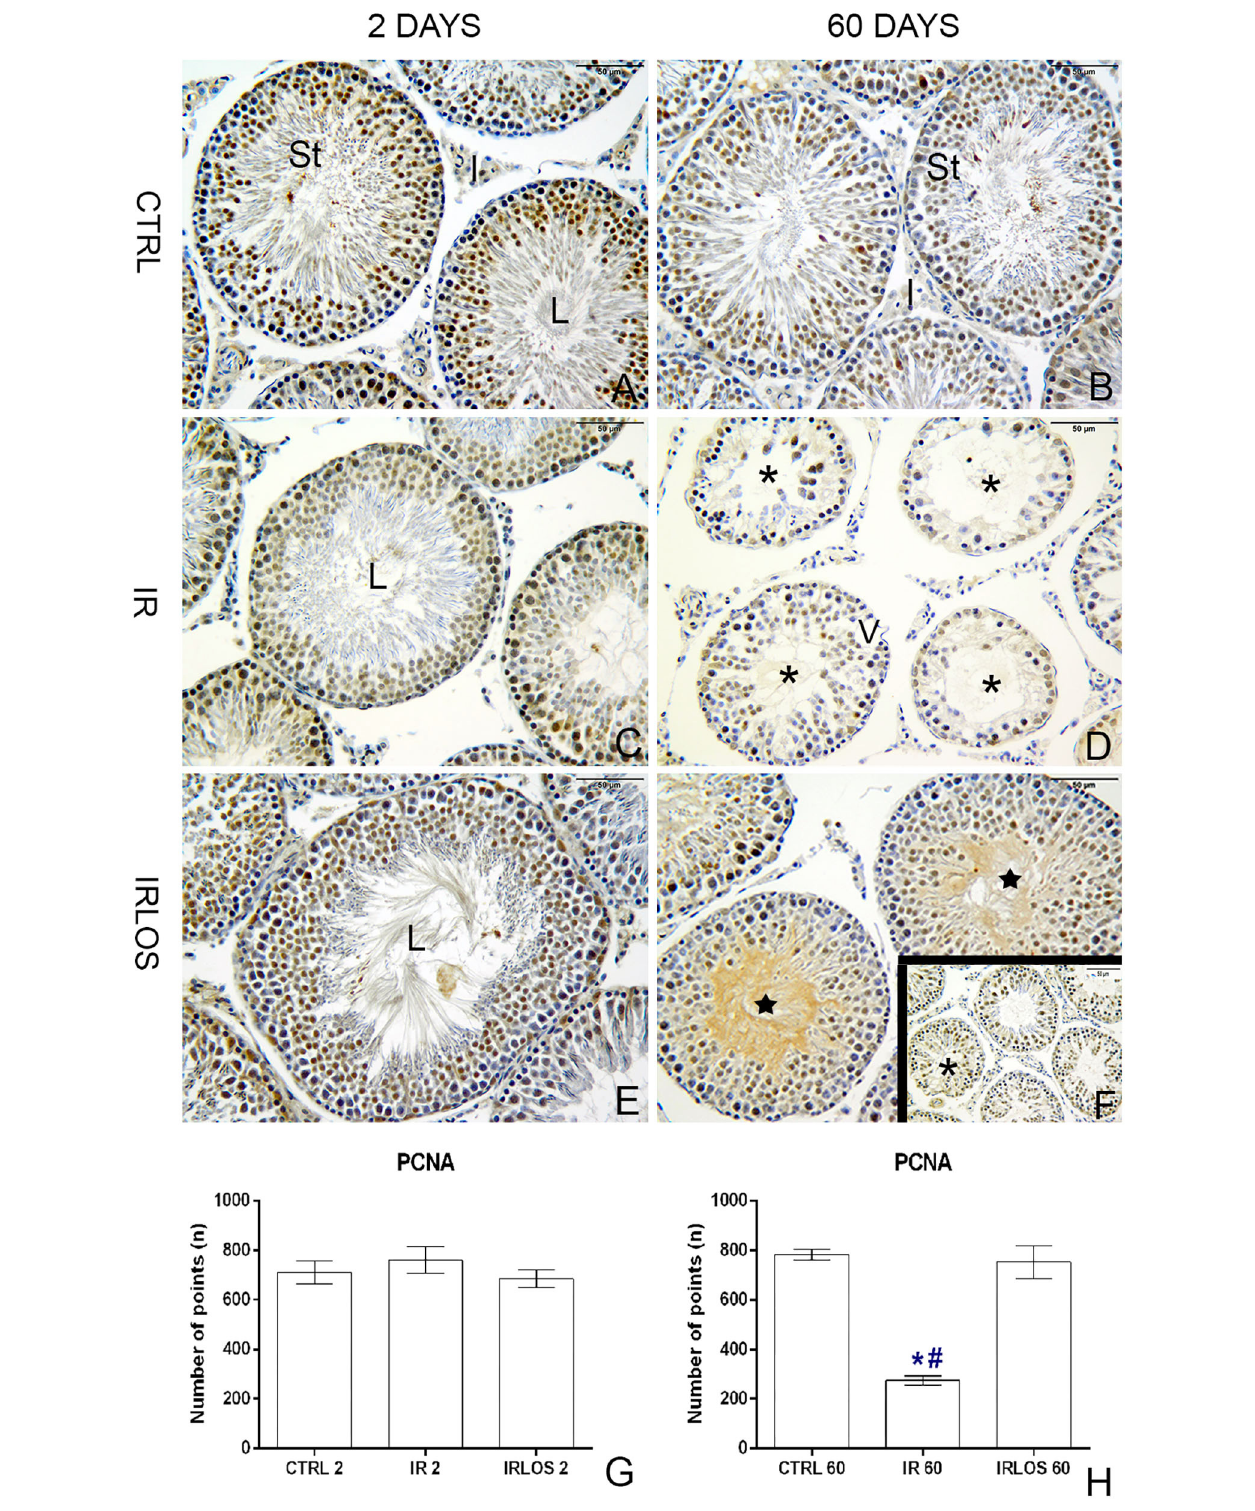
FIGURE 5 | PCNA immunohistochemistry of the testes from controls (A,B), rats exposed only to irradiation (C,D), and rats exposed to radiation and treated with losartan (E,F,F-inset) after 2 and 60 days to the exposure. Positive reactions were observed in many nuclei of seminiferous tubule cells of the testes from